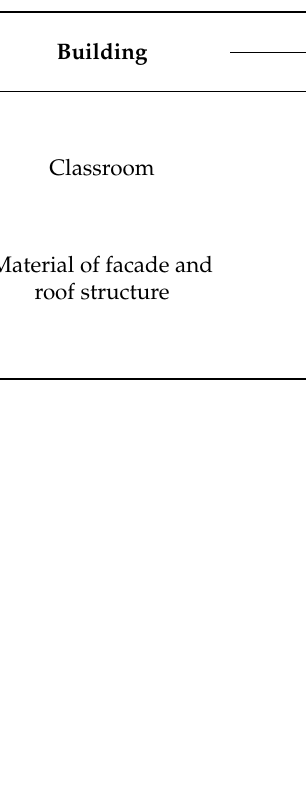
Figure 1. Image and floor plan of a typical high-school building. Table 1. Setting condition of school building model.